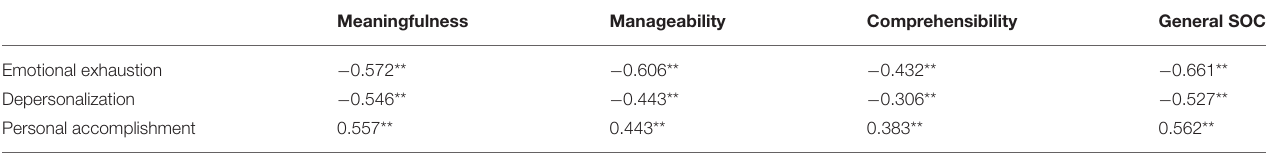
TABLE 3 | Correlations between SOC and MBI scales.